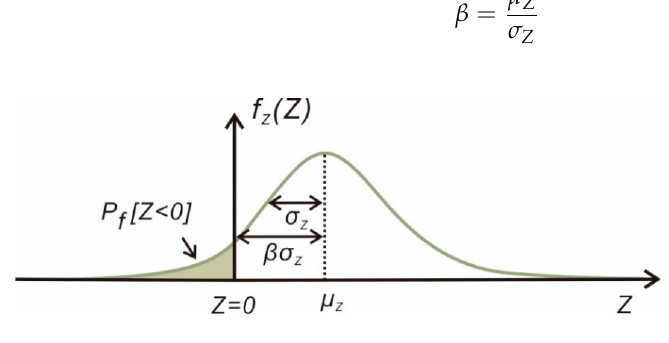
Figure 3. Definition sketch of failure probability in Level II method. MPFP denotes a point where the reliability function’s probability density function reaches its peak along the line 0 = Z (limiting state).